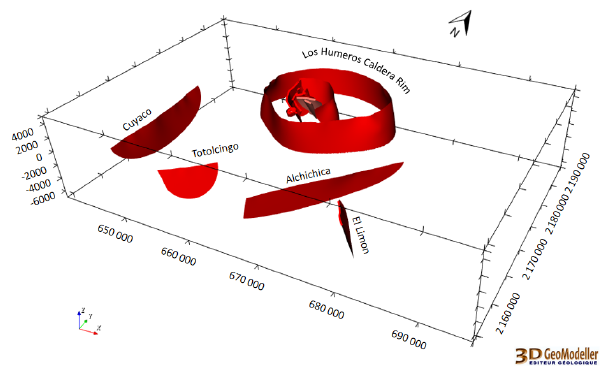
Figure 9. The Los Humeros regional fault model, including twelve faults inside the caldera rim and four outside. The latter are inferred by López-Hernández et al. (1995) with no field evidence. Coordi- nate system is WGS84/UTM zone 14N.